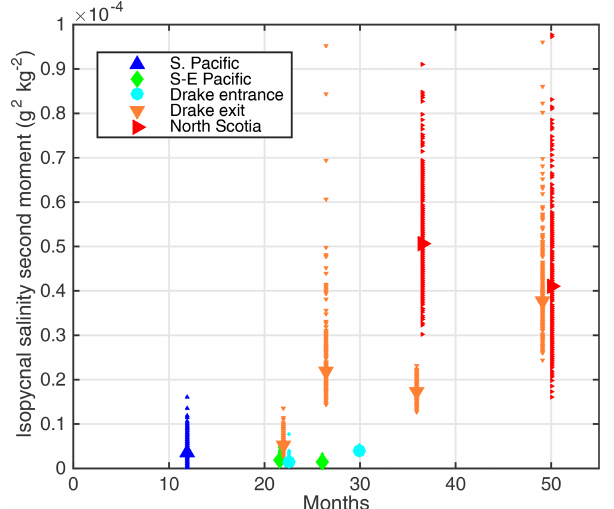
Figure 5. Isopycnal second moment of the tracer in salinity coor- dinates derived from the Gaussian fits in Fig. 3 versus time since release. Each small marker (making up the error bars) represents a single member of the bootstrap ensemble, and the larger marker the result of using all the data.